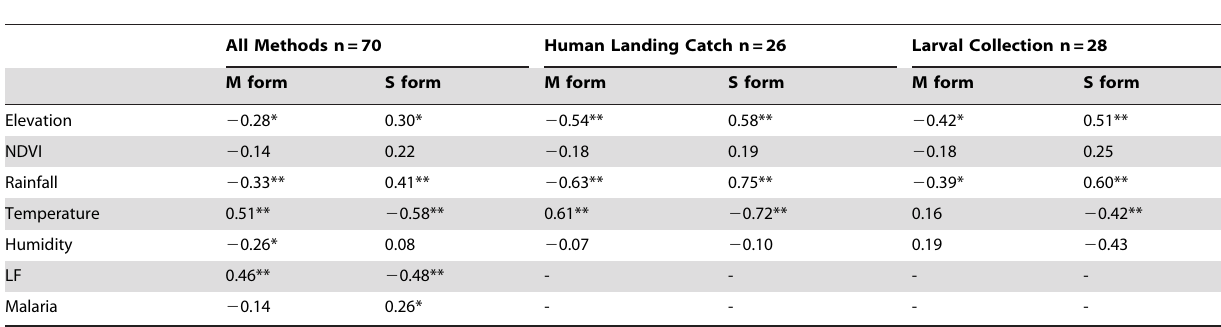
Table 1. Bivariate correlations between An. gambiae s.s. molecular forms and environmental and epidemiological variables.